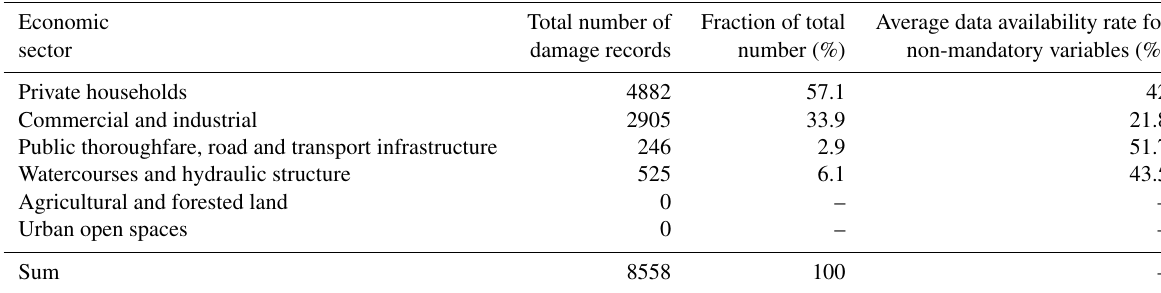
Figure 2. Left plot: locations of available flood damage data in HOWAS 21 (adapted from Kreibich et al., 2017b). Right plot: number of damage cases per economic sector and event. No data are yet available for the sectors agricultural and forested land and urban open spaces. Table 2. Total number of damage records per economic sector in HOWAS 21 and average data availability rate for non-mandatory variables according to the defined minimum requirements for data incorporation into HOWAS